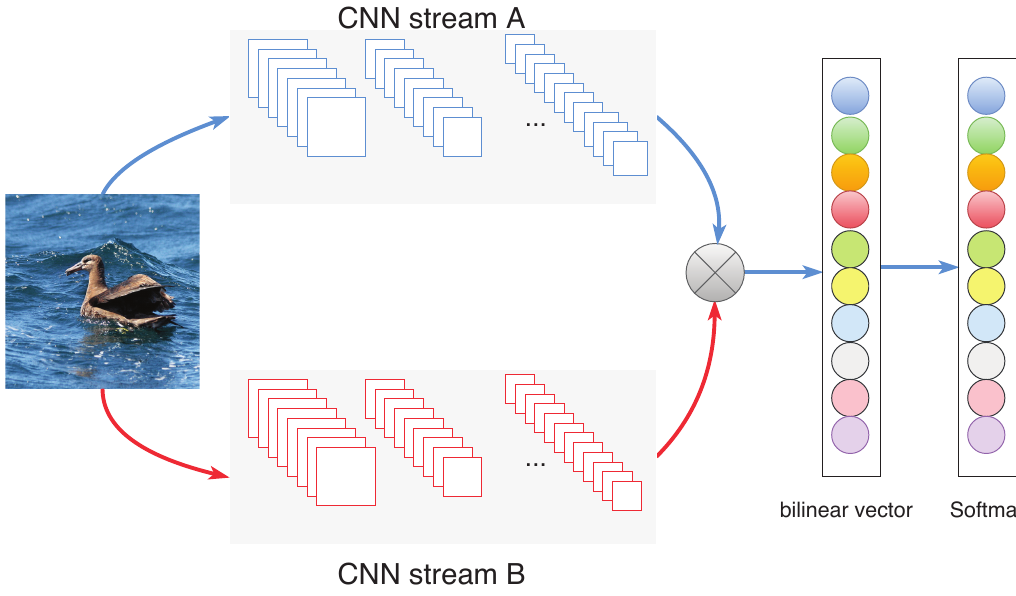
Figure 5. Image classification by a bilinear convolutional neural network (B-CNN). An image is passed through CNNs A and B. The CNN outputs at each location are combined using the matrix outer product and then average-pooled to obtain the bilinear feature representation. After passing the feature representation through a linear softmax layer, the class prediction is obtained [24].